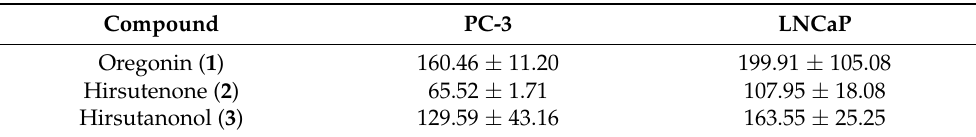
Figure 1. Structures of the three diarylheptanoids isolated from Alnus sibirica , oregonin ( 1 ); hir- sutenone ( 2 ); hirsutanonol ( 3 ). Table 1. Anti-proliferative activity of the three diarylheptanoids ( 1 – 3 ) isolated from Alnus sibirica against PC-3 and LNCaP cells (IC 50a , µ